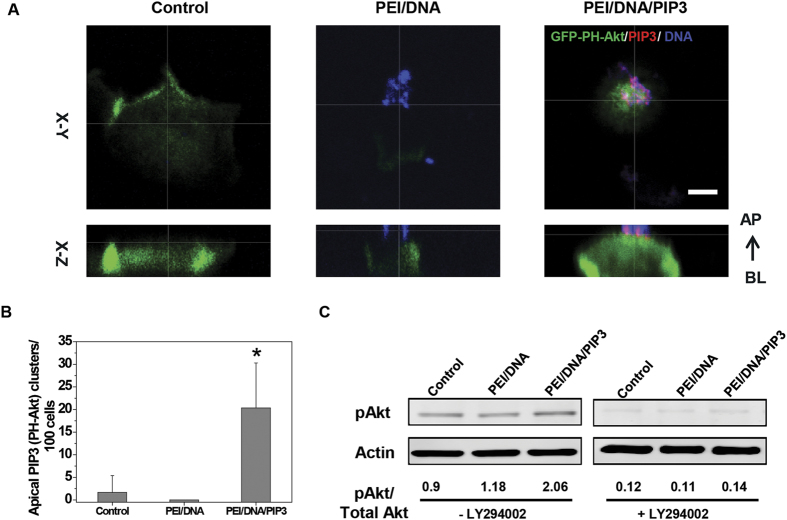
Apical incubation of MDCK cells with PEI/DNA/PIP3 polyplexes leads to PI3-Kinase activation.(A) Polarized MDCK cells stably expressing GFP-PH-Akt (green) were treated with PEI/DNA/PIP3 or PEI/DNA complex, or without any treatment (control). Plasmid DNA was labeled by Cy5 (blue), PIP3 was labeled by BODIPY-TMR (red). Scale bar is 5 μm. (B) The presence of apical PIP3 (PH-Akt) clusters was quantified from three independent experiments; per condition 80-100 cells were analyzed. Data are presented as mean ± SD. Two-tailed t-test was used to determine statistical difference between each treatment group and control. *p = 0.006. (C) MDCK cells were treated with PEI/DNA, and PEI/DNAPIP3 complexes. Cell lysates were analyzed for phosphorylated Akt and total Akt expression by Western blotting. Actin served as a loading control. The numbers below the lanes indicate the phospho-Akt/total Akt ratio.